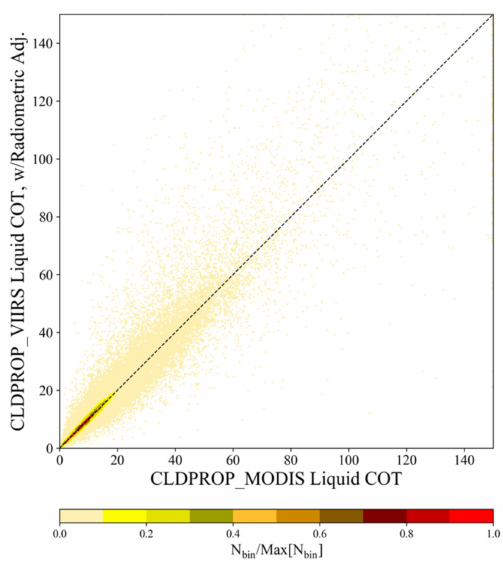
Figure 5. Same as Figure 1c, except for the CLDPROP_VIIRS liquid COT that has been retrieved after applying the SNPP VIIRS radiometric adjustment factors in Table